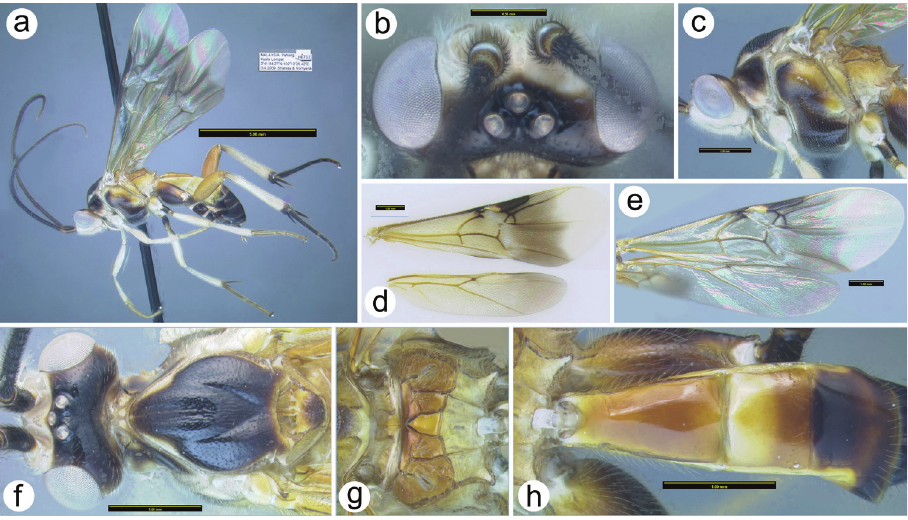
Figure 7. Zelodia idrisi sp.n. a lateral habitus b dorsal head c lateral head and mesosoma d wings with buffered light source e wings with normal light source f dorsal head and mesosoma g dorsal propodeum h dorsal